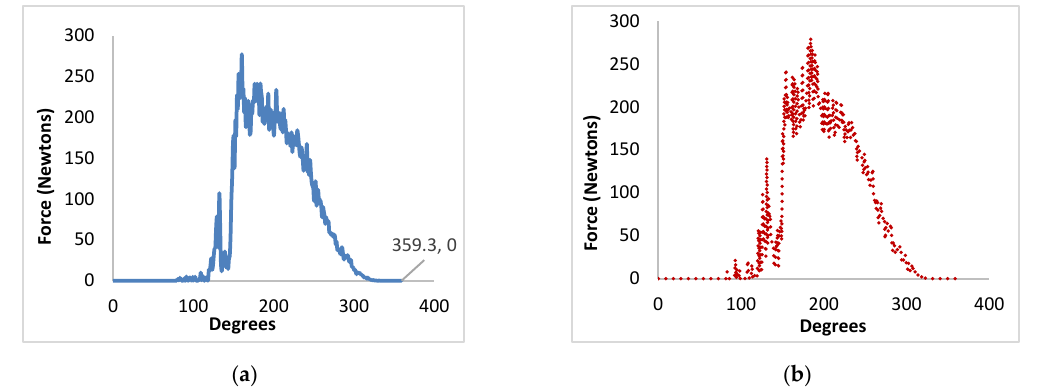
Figure 13. Comparison of average shell liner force profiles for ( a ) 25 mm balls and ( b ) 35 mm balls.